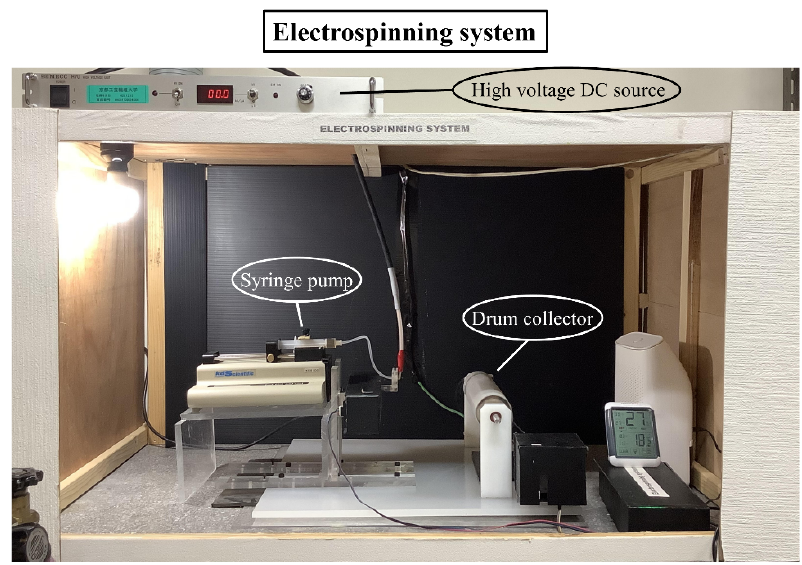
Figure 1. Photograph of the electrospinning system used.